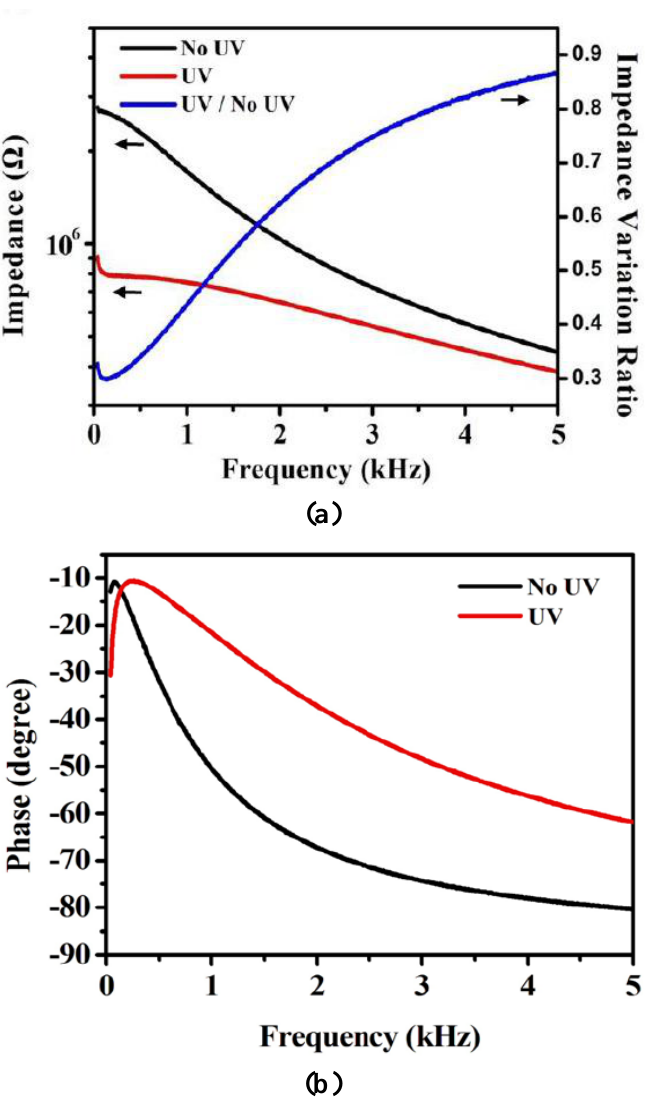
Figure 2. Electric properties of the LC/SP employed to replace the traditional electrode for modal sensor applications: (a) impedance and (b) phase measurements of the LC/SP under treatment of shading and UV irradiation using an impedance analyzer (Agilent